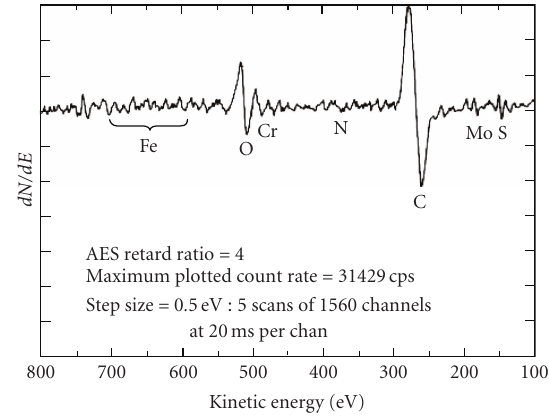
Figure 2: AES of Grease B at just before weld load; 280kg.